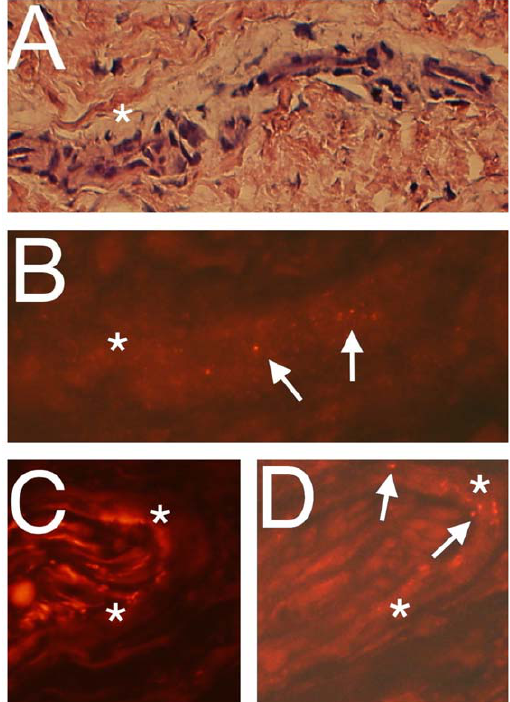
Figure 2. Immunofluorescence for CB 1 in Achilles tendinosis. Panels show sections of Achilles tendinosis tendons processed for demonstration of CB 1 ( a,c,d ) and of CB 1 after preabsorption with the immunogenic peptide ( b ). Numerous tenocytes are seen in low magnification in ( a ) and ( b ) (arrows at tenocytes). They show specific immunoreactions in ( a ) but not in ( b ). In panel c and d in which the tenocytes are shown in high magnification, punctuate immunoreac- tions in tenocytes are shown (arrows). Original magnification 6 20 ( a,b ), 6 63 ( c,d ).